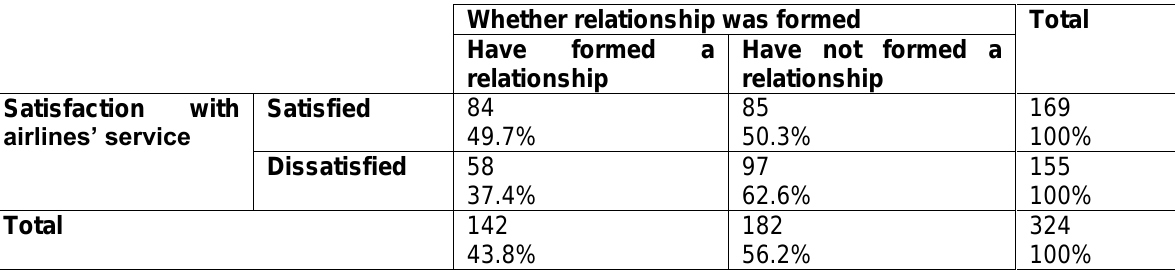
Table 2: A cross-tabulation between whether respondents have formed relationships with the airlines and their satisfaction with the airlines’ service Whether relationship was formed Total Have formed Have not formed a relationship relationship Satisfaction with airlines’